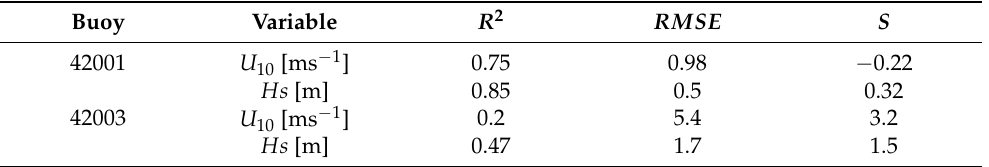
Figure 3. Time evolution of U 10 and Hs computed by HWRF and WW3 models, respectively, as well as the observations from the NDBC buoys 42001 ( left panels ) and 42003 ( right panels ). Table 4. Statistical validation for the wind intensity, U 10 , and the significant wave height, Hs , computed by the models at the corresponding positions of the NDBC buoys 42001 and